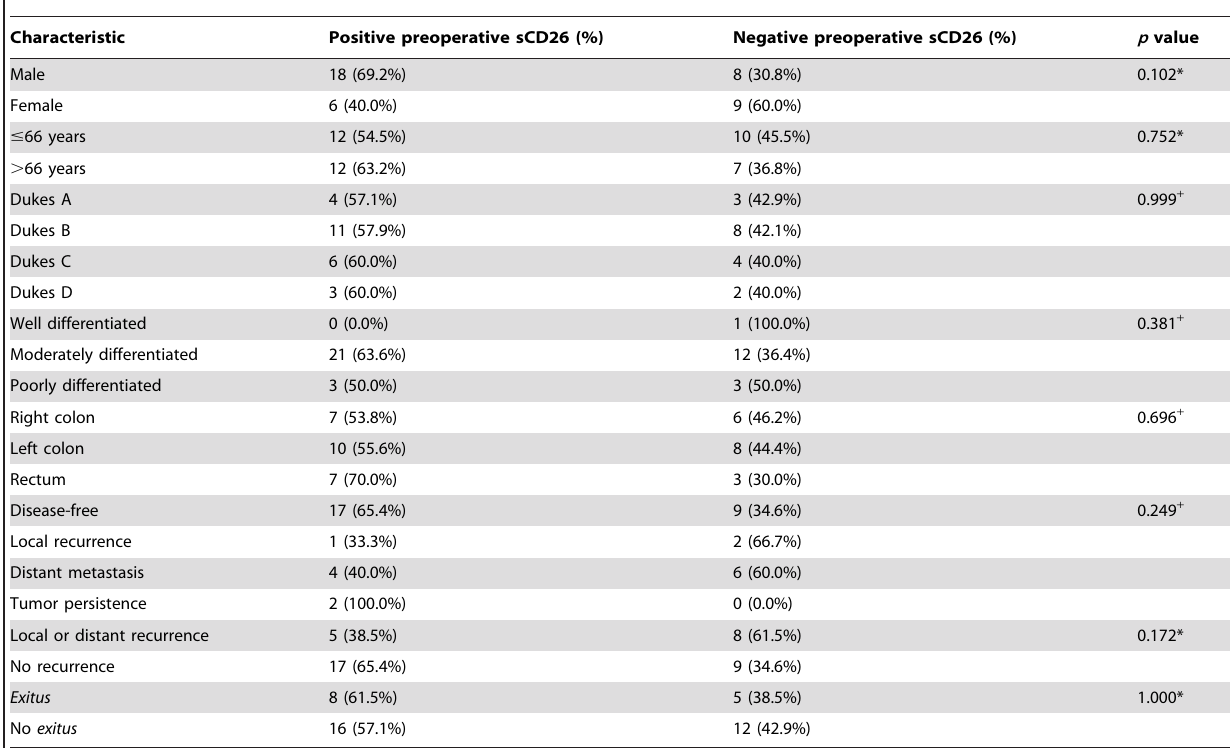
Table 1. Clinical and epidemiological characteristics of the patients according to the preoperative sCD26 levels.